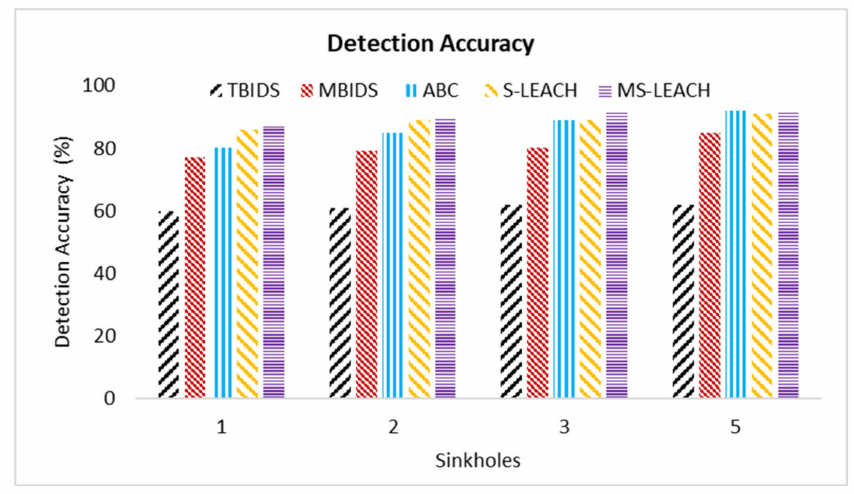
Figure 12. Energy consumption for a small-scale network with 1, 2, 3, and 5